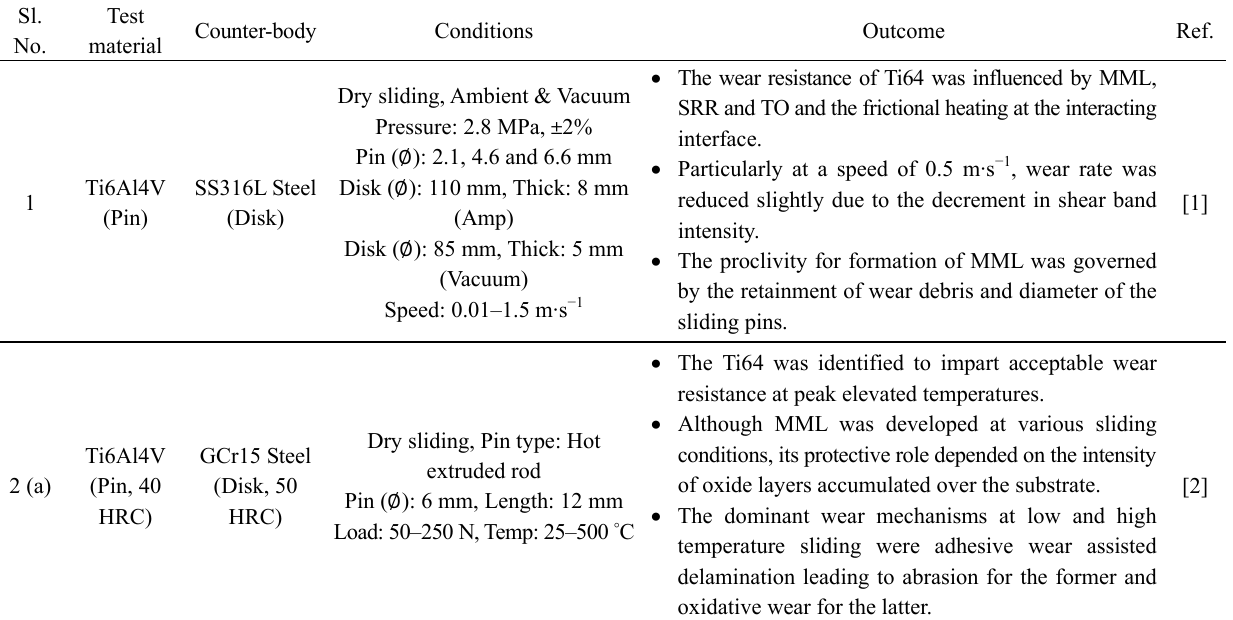
Table 2 Distinction in tribo-behavior of Ti64 sliding against discrete counter-body surfaces.